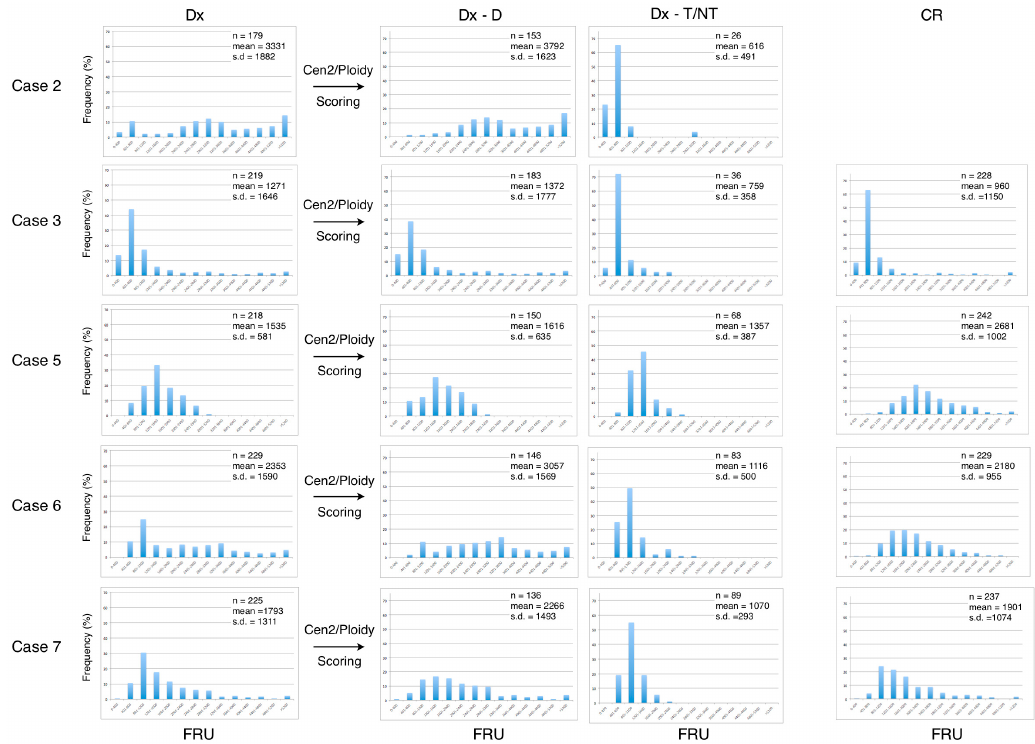
Figure 4. Quantification of telomere content in bone marrow cells at diagnosis (Dx) and at complete remission (CR) in the AML disease group. The FRU values were grouped and frequencies were normalized at Dx, and after ploidy scoring into Dx-Diploid and Dx-T/NT nuclei as well as at CR. At CR there were no clonal T/NT cells present in either of the samples. In the upper right corner of each histogram is indicated: the number of analyzed cells (n), the mean values, and standard deviation (SD).